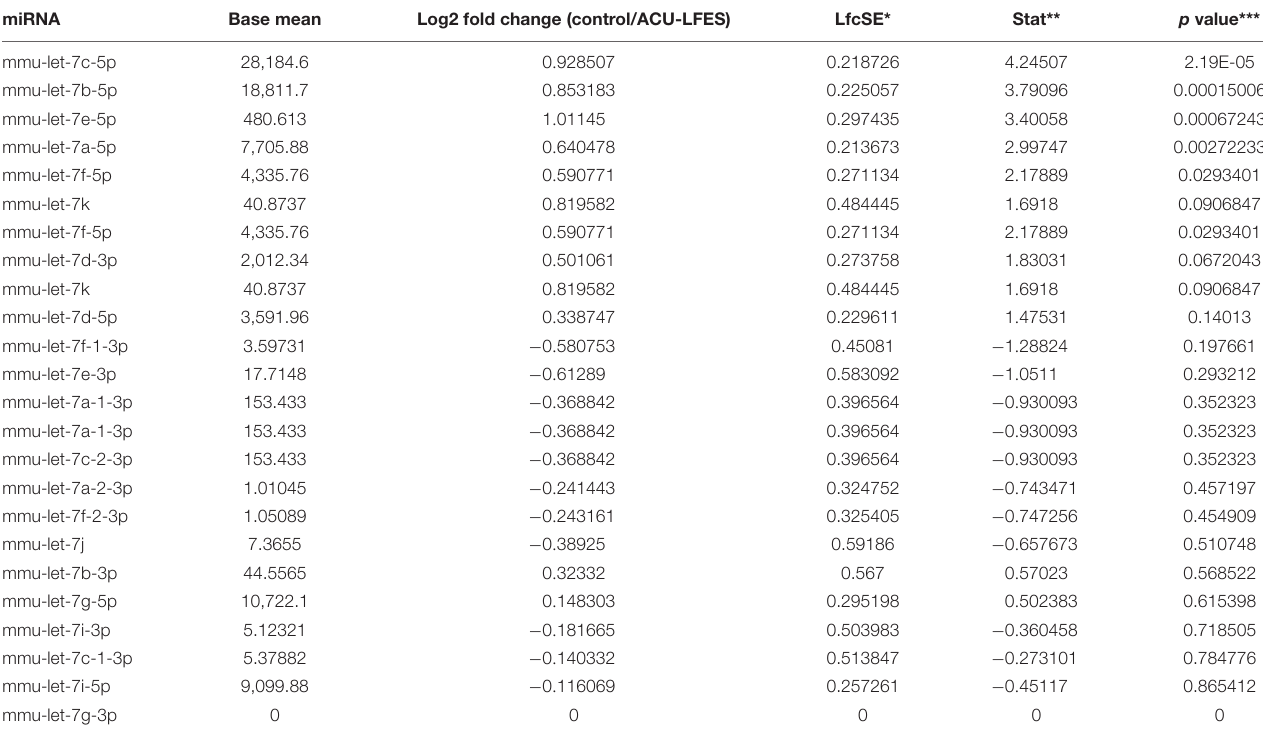
TABLE 1 | Let-7s are decreased by Acu/LFES in serum exosome. miRNA Base mean Log2 fold change (control/ACU-LFES) LfcSE* Stat** p